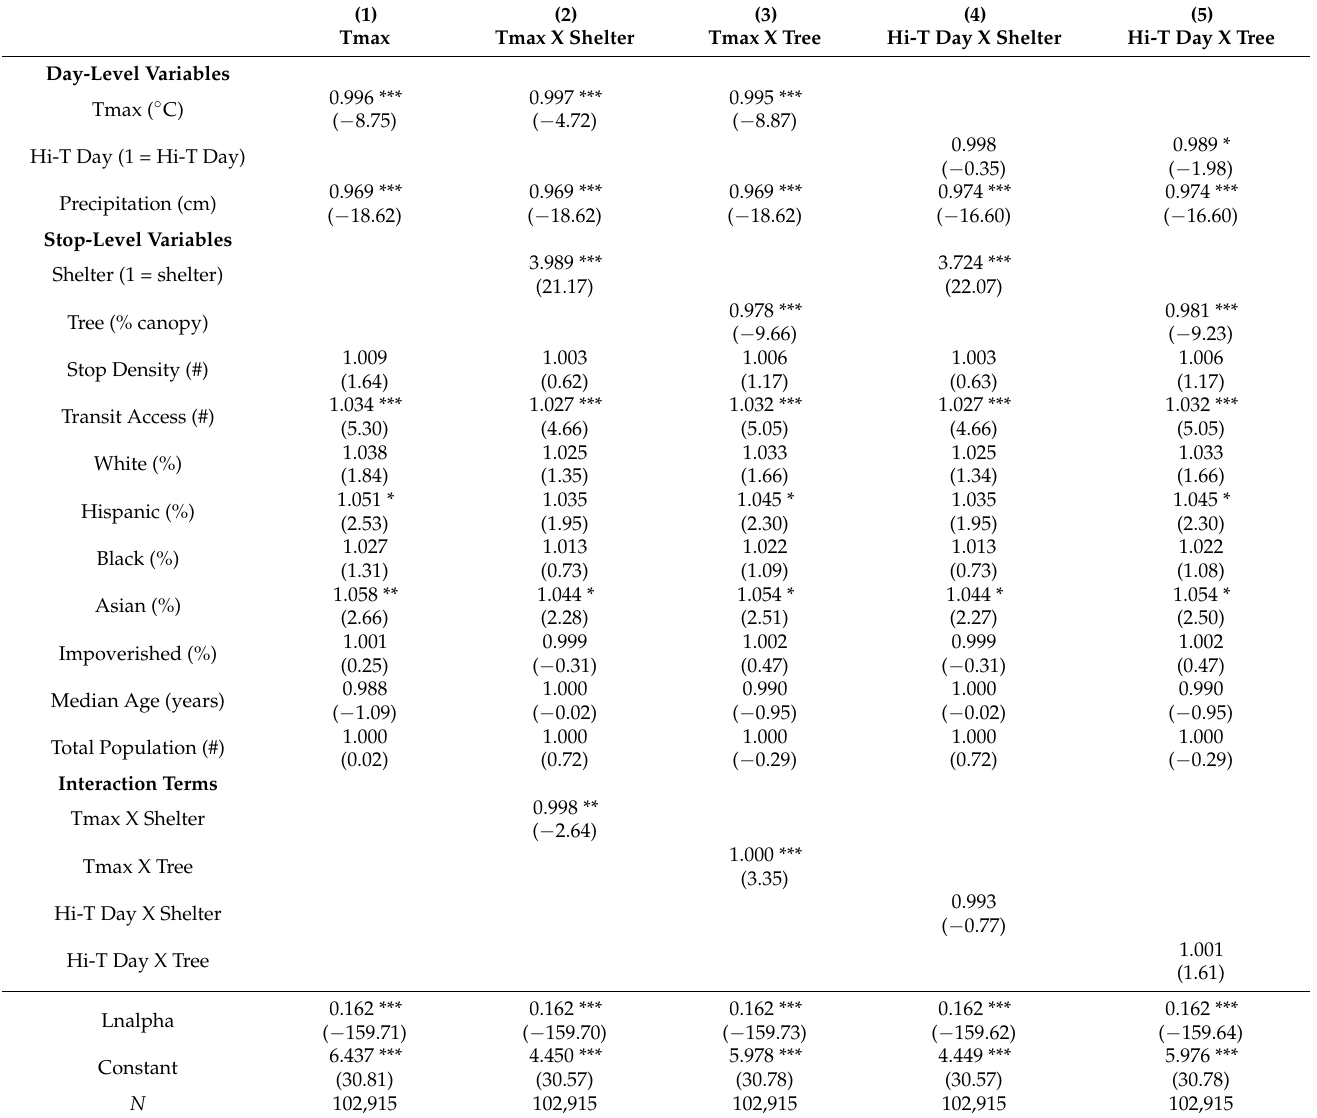
Table A1. Model output for relations between temperature, bus stop shelters, tree canopy, ridership, and